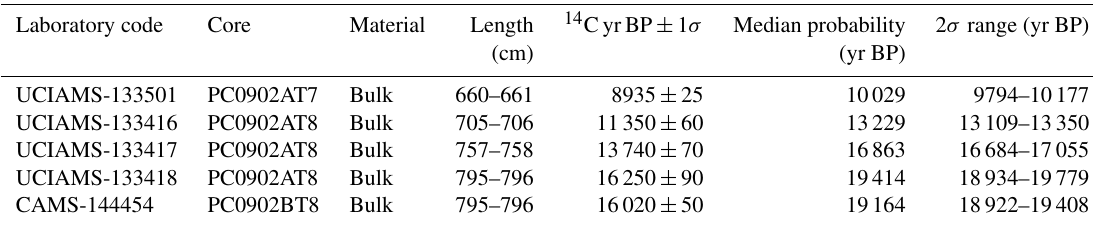
Figure 3. Age model of the Lago Edita record, with the blue zones representing the probability distribution of the calibrated radiocarbon dates and the grey zone representing the calculated confidence interval of the Bayesian age model. Table 1. Radiocarbon dates from the Lago Edita core. The radiocarbon dates were calibrated to calendar years before present using the CALIB 7.0